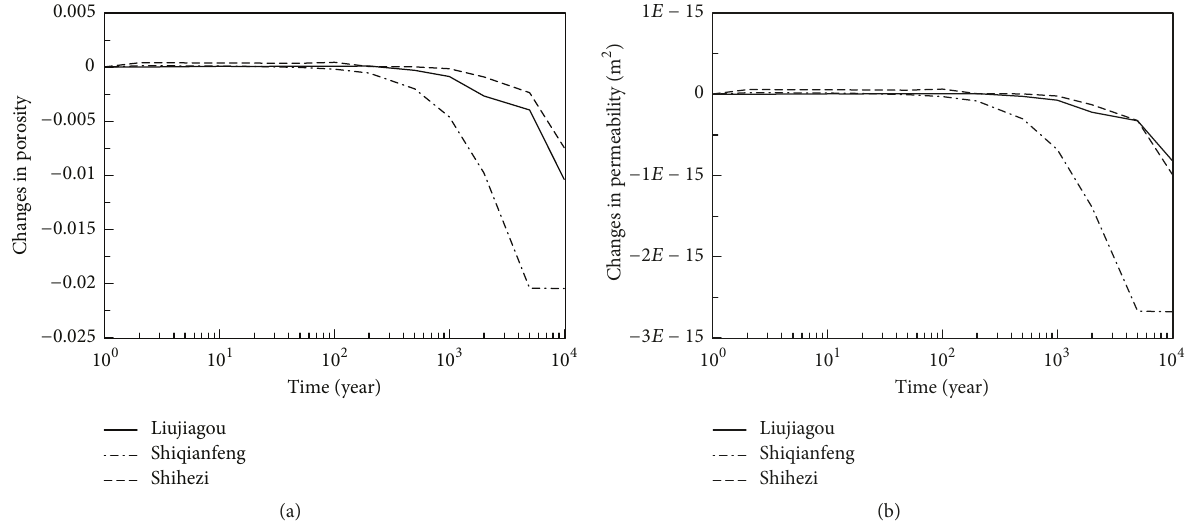
Figure 11: The evolution of changes in porosity (a) and permeability (b) at point A for the three formations over time.